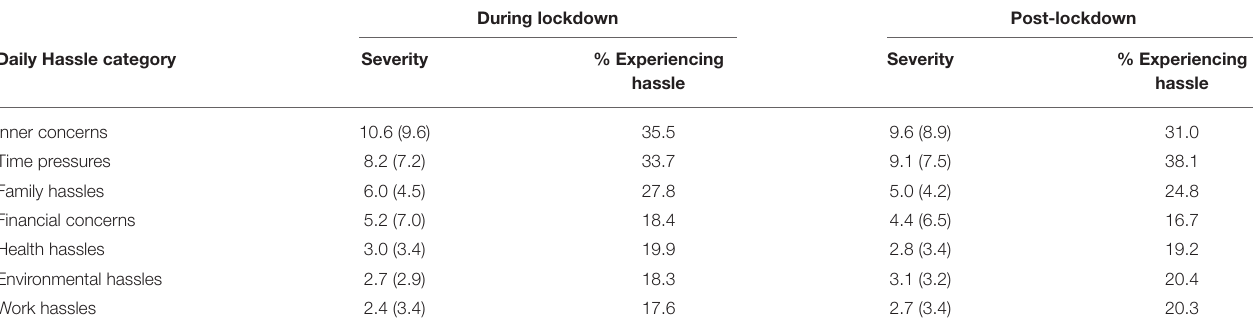
TABLE 3 | Mean (SD) severity of daily hassles experienced and percentage of sample experiencing specific hassles during and post-lockdown. During